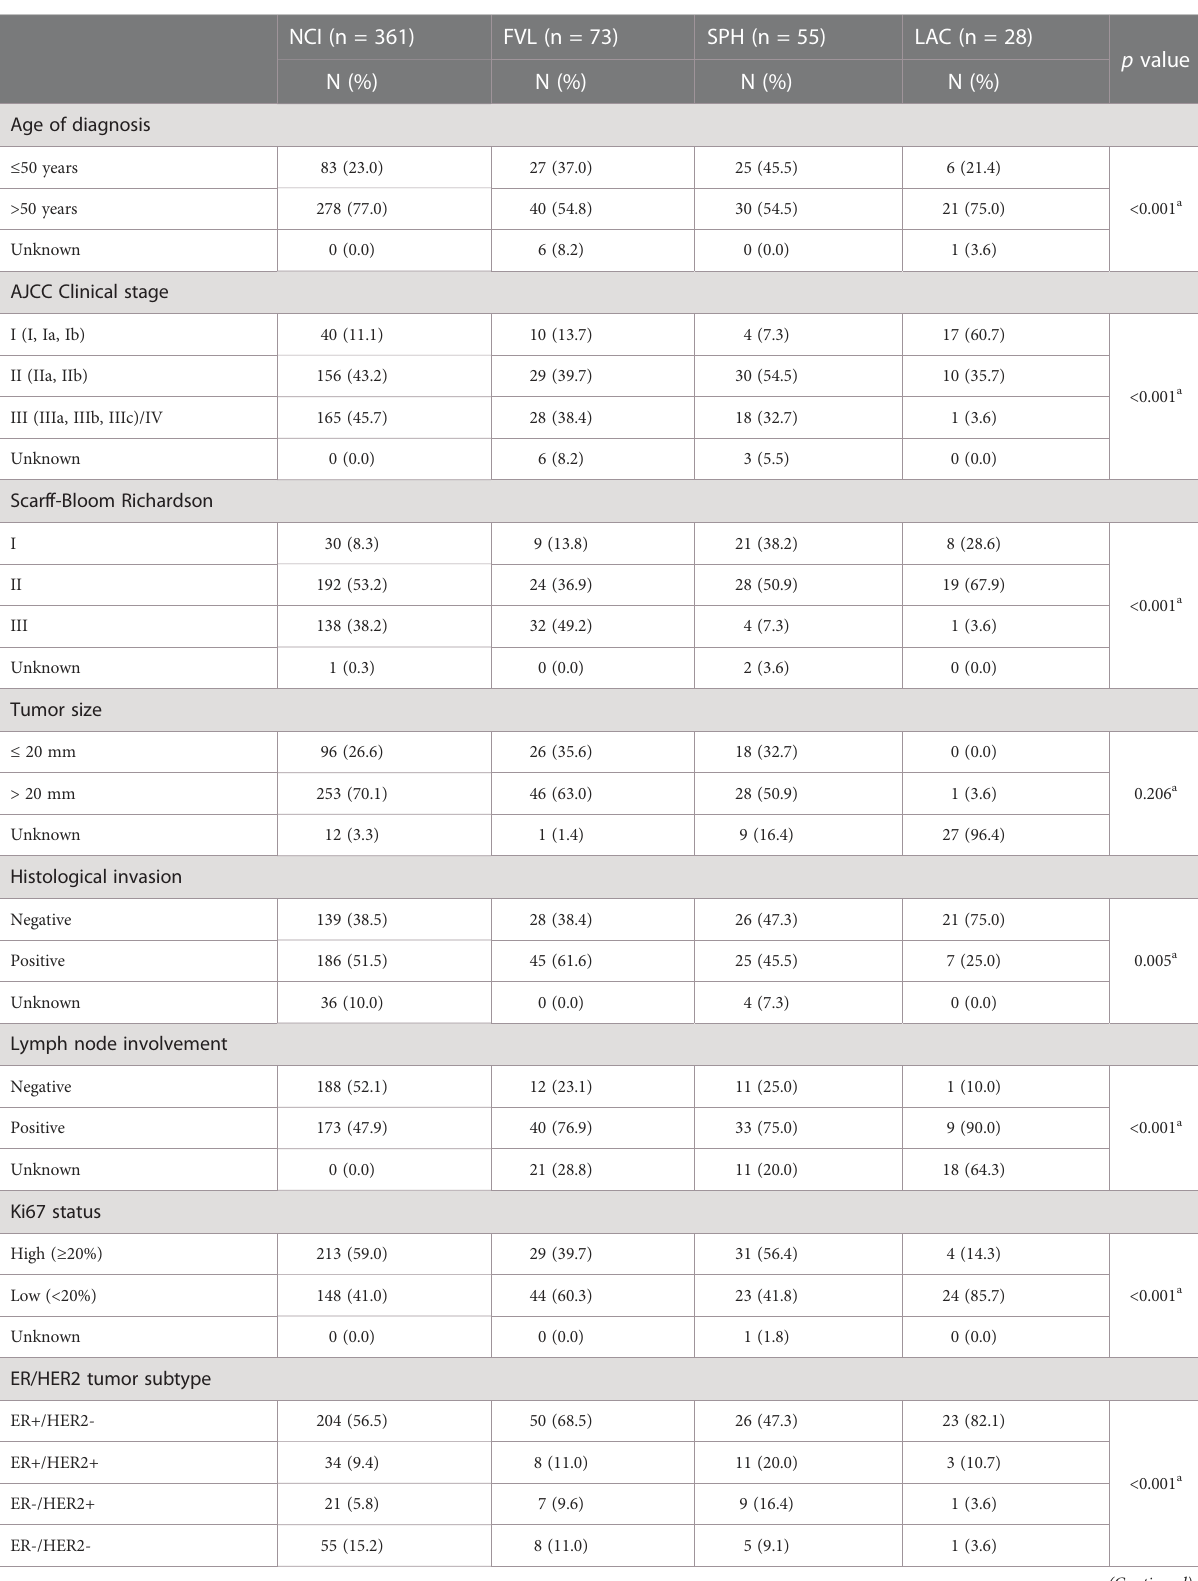
TABLE 1 Clinical-pathological characteristics of patients by health